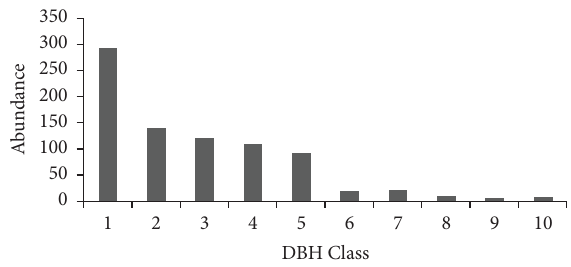
Figure 4: DBH classes of matured woody plant species of Zijje Maryam Church Forest/2020. Key: numbers represent the